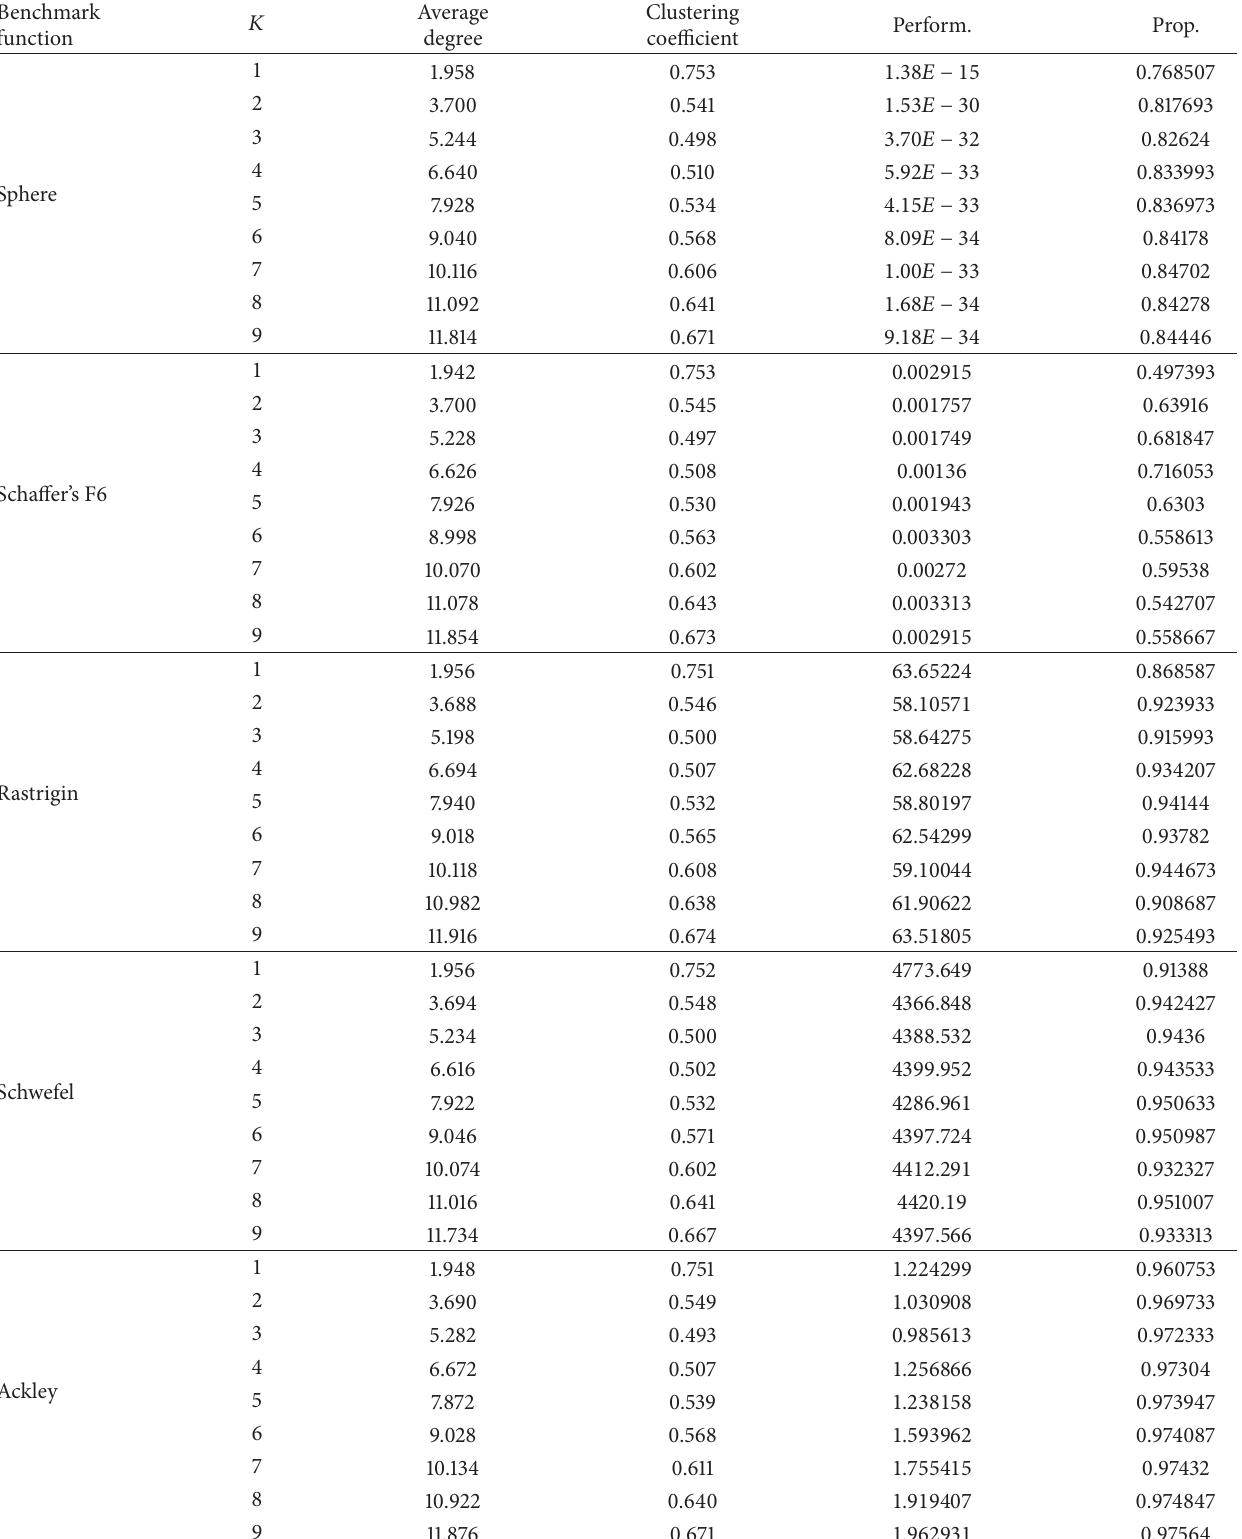
Table 3: Comparison between random topologies with different average